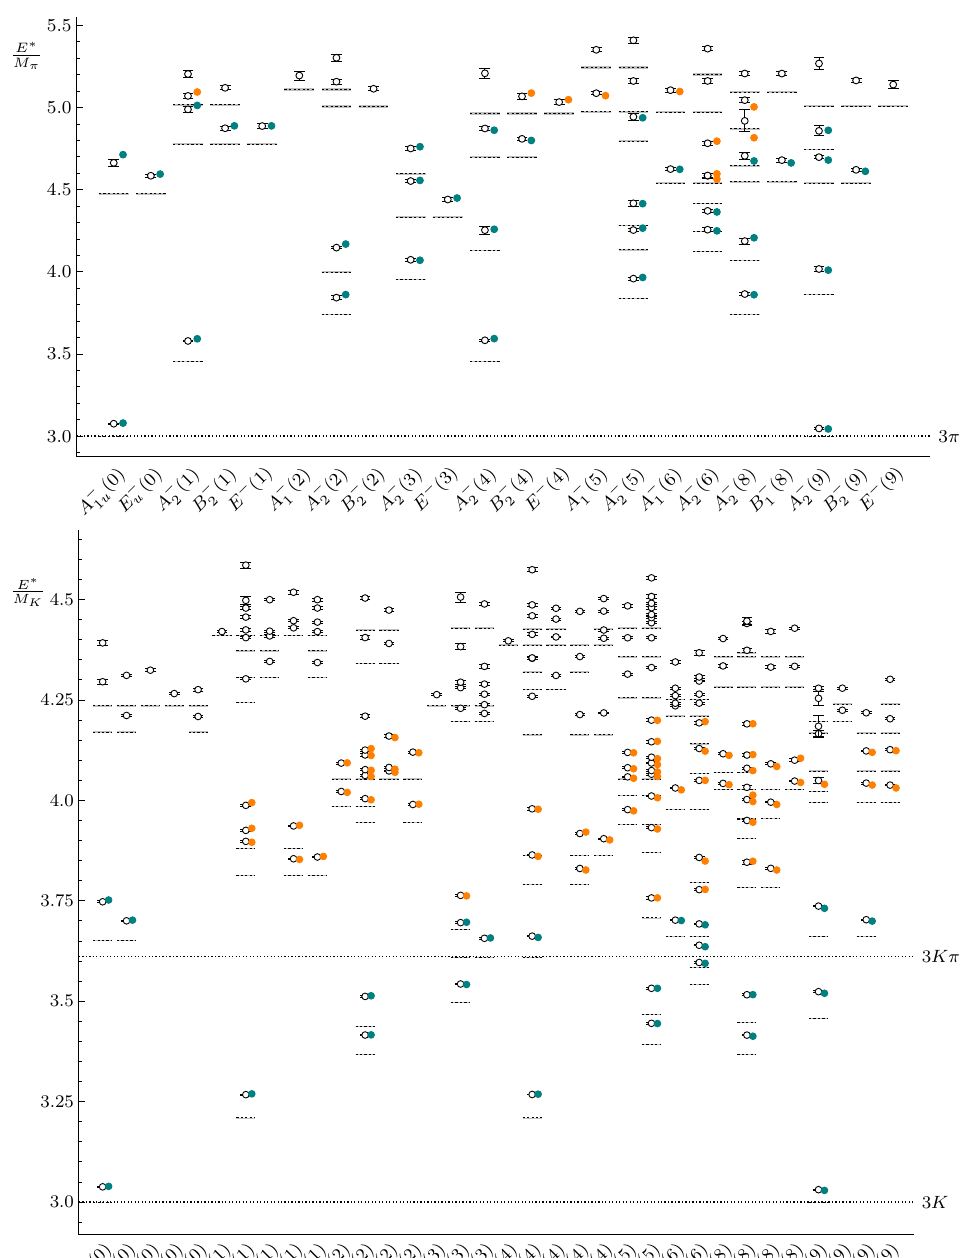
Figure 3. Center-of-mass energies of three pions (top) and three kaons (bottom) on N200. The various irreps and momentum-squared are listed at the bottom. The dashed lines specify the free energy levels, and the open circles denote the interacting energies. Free energy levels may be degenerate — see appendix B. Several thresholds are indicated with dotted lines. The colored circles indicate the central values of the resulting energies from a global fit to the two- and three-particle quantization condition; we use the parameters from fit 3 of table 5 and fit 4 of table 10 for the pion and kaon spectra, respectively. The teal and orange circles correspond to energies included and not included, respectively, in the